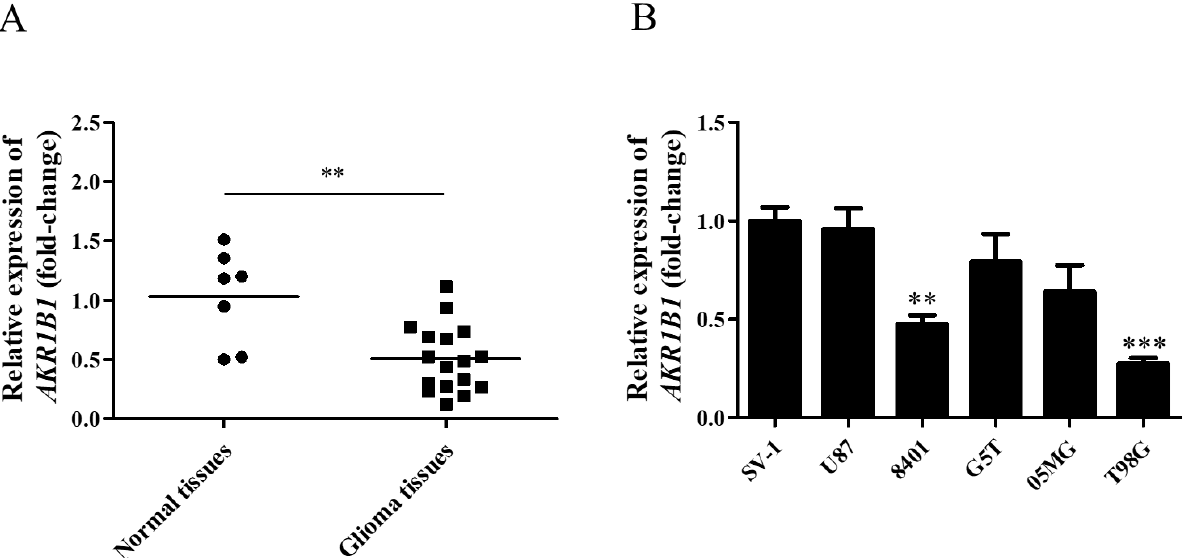
Figure 1. AKR1B1 mRNA levels in human glioma tissue and cell lines. ( A ) AKR1B1 mRNA expression in glioma (squares) and normal brain (dots) tissues. ( B ) Comparison of AKR1B1 mRNA levels between various glioma cell lines and SV-1 cells ( n = 3/cell type). Data are presented as mean ±